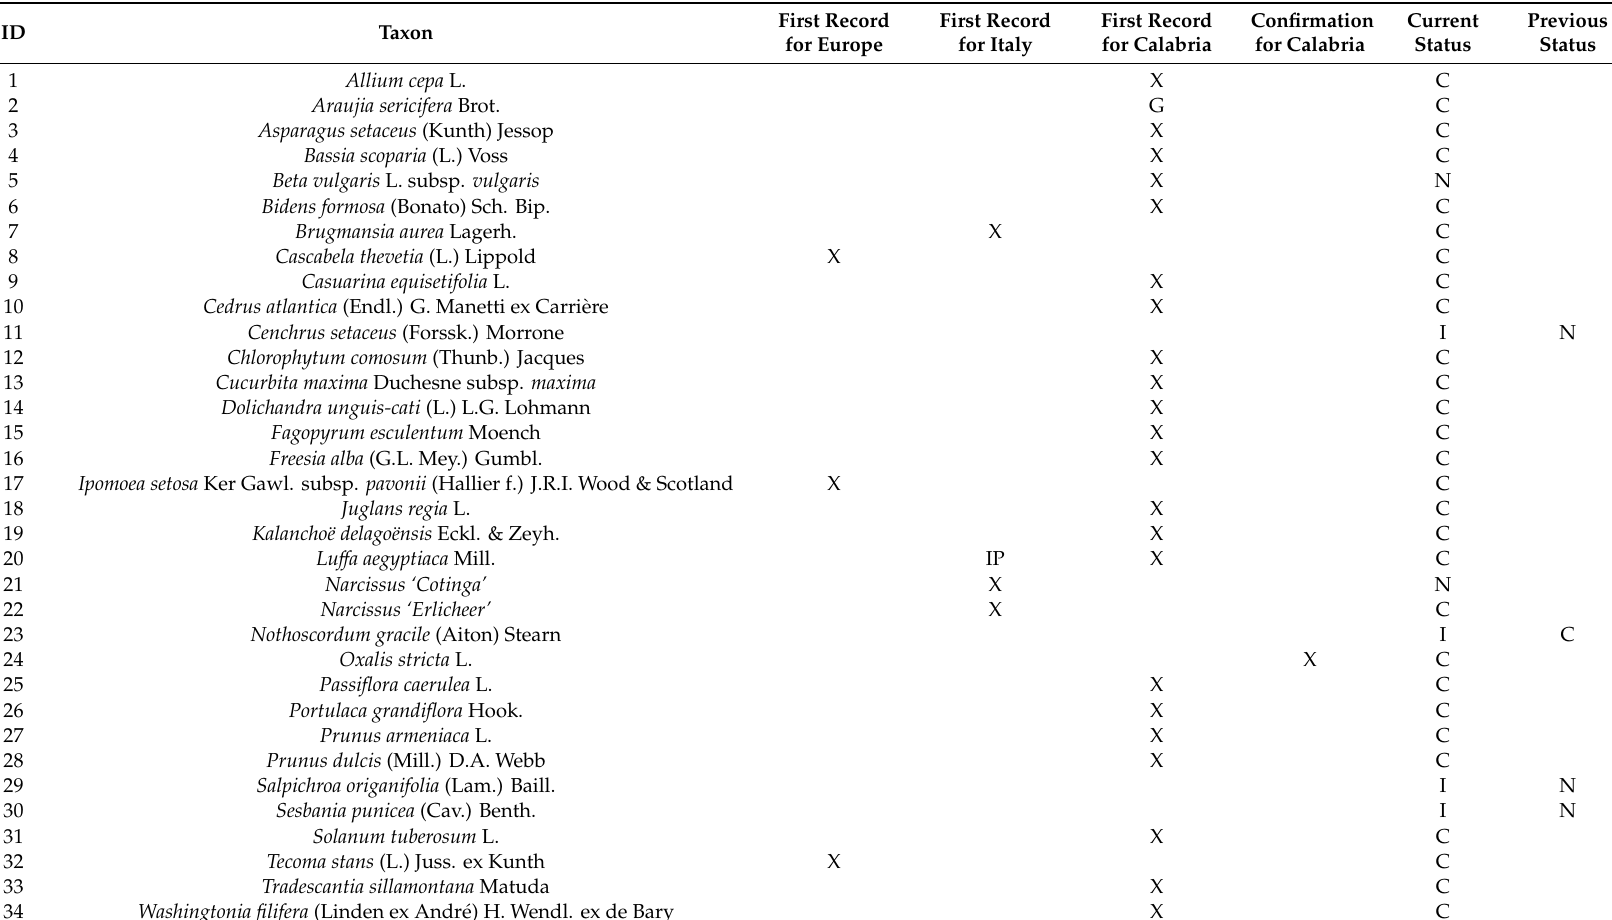
Table 1. List of the 34 alien taxa recorded for the flora of Calabria (Southern Italy, Europe), with their eventual first record for Europe, first record for Italy, or confirmation for Calabria, and finally, the current status of invasiveness in the region and the previous one if